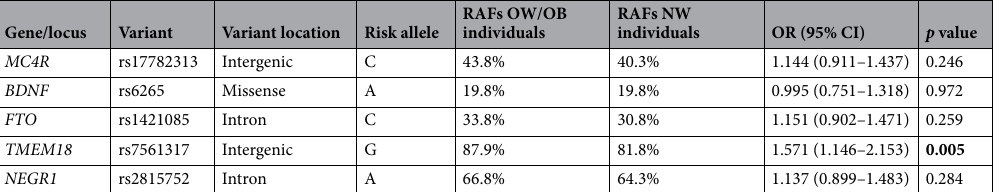
Parameters (unit of